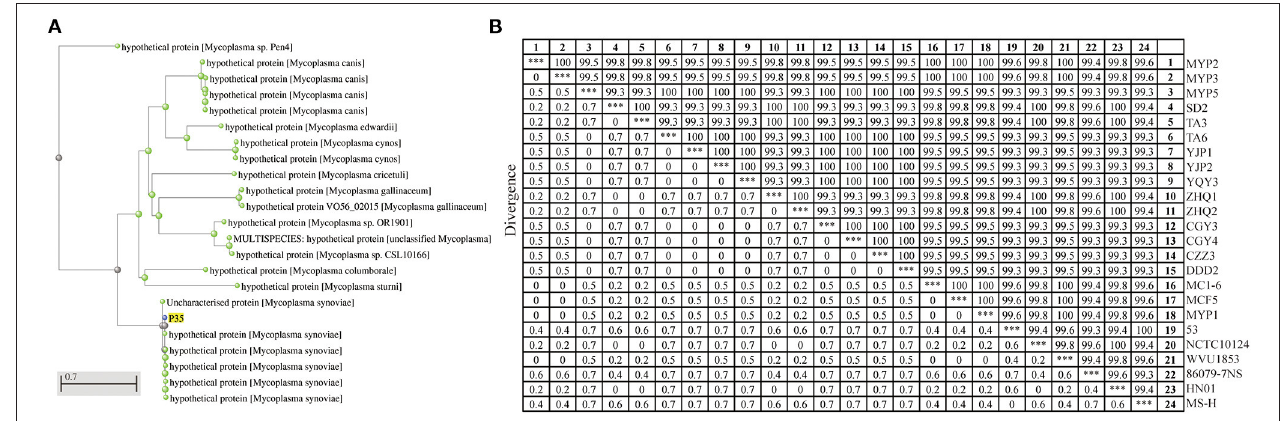
FIGURE 1 | Homology analysis of P35. (A) Molecular evolutionary tree analysis of P35. This tree was drawn on National Center for Biotechnology Information (NCBI) after being blasted with amino acid sequences of P35. The green points mean the blasted results of P35, and the blue point is P35. (B) Sequence distance of p35 gene among different Mycoplasma synoviae (MS) strains. A total of 24 sequences were used to calculate the homology by MegAline, among which 18 sequences were amplified and sequenced from MS isolates, and 6 sequences (53, NCTC10124, WVU1853, 86079-7NS, HN01, and MS-H) were obtained from NCBI database. ***The consistency of the same strain, which means 100% similarity.